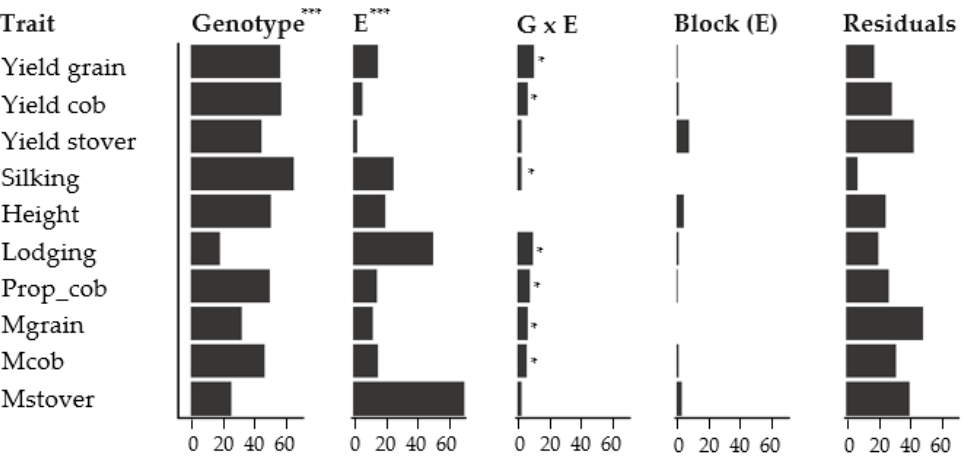
Figure 2. Percentage of phenotypic variance explained by each analysis of variance with the model fit as random effects for 10 quantitative traits—yield of grain, cob, and stover; flowering time (silking); plant height; proportion of cob (prop_cob); lodging; moisture of the grain (Mgrain); cob (Mcob); and stover (Mstover)—measured on twenty lines in four environments in Pontevedra (Spain), 2010 and 2011. Genotype (G), environment (E). * and *** denote significance at p = 0.05 and p = 0.001, respectively.